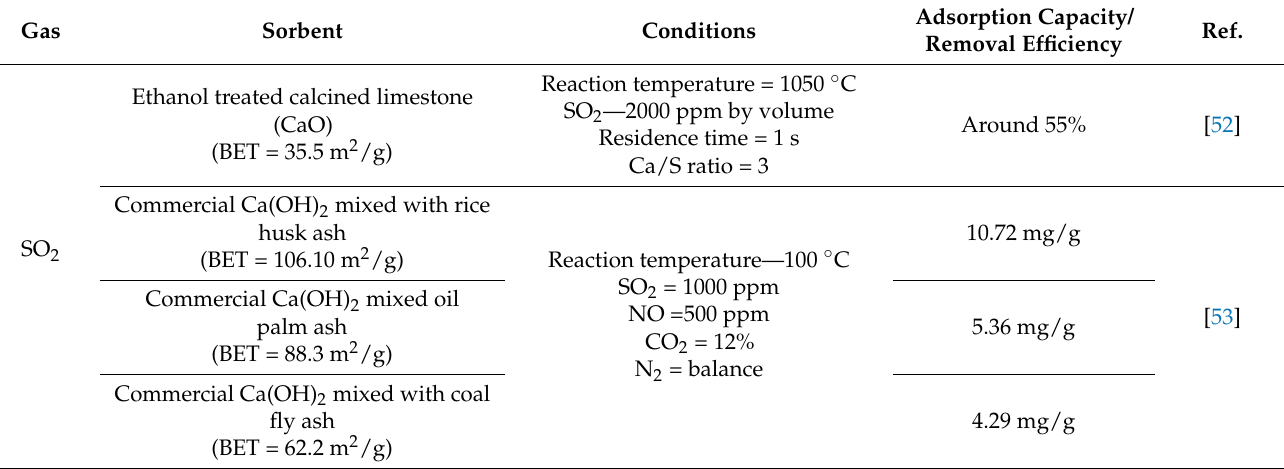
Table 7. Comparison of raw and calcined (900 ◦ C) eggshell with other Ca-based sorbents for SO 2 and H 2 S. Gas Sorbent Conditions